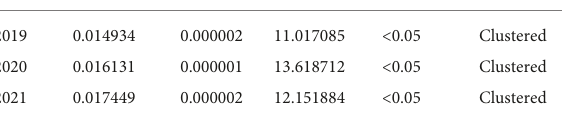
TABLE 3 Spatial autocorrelation analysis of visceral leishmaniasis incidence in mainland China from 2019 to